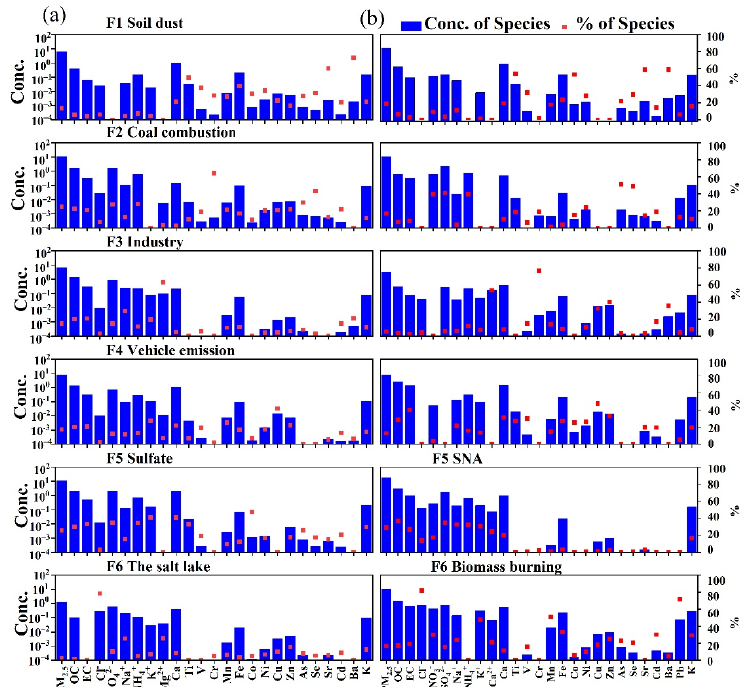
Figure 7. PMF factor profiles and chemical compounds in summer (( a ) factor profiles for daytime, ( b ) factor profiles for nighttime). The columns are the concentrations of each species within a given source, and the dots represent the percentage contribution of the species to each factor.